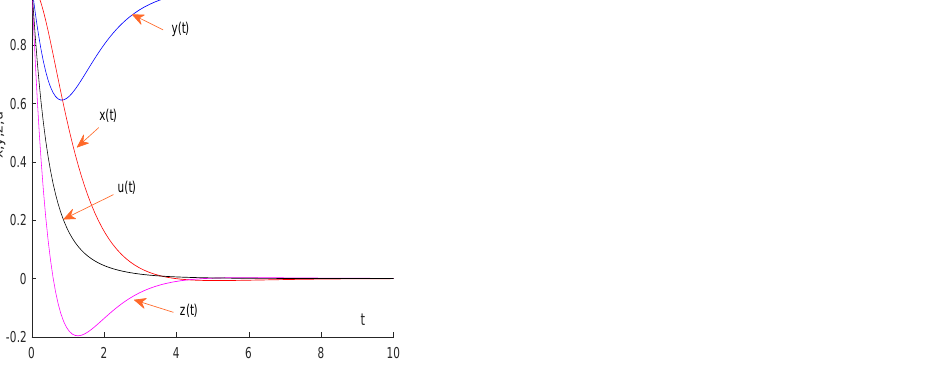
Figure 6. The time series of the four variables around the attractor P 1 in the system (3). The parameters are a = 1, b = 1, c = 2, m = − 1 and d = 1. The starting point of these series is ( 1,1, 1, 1 ) .